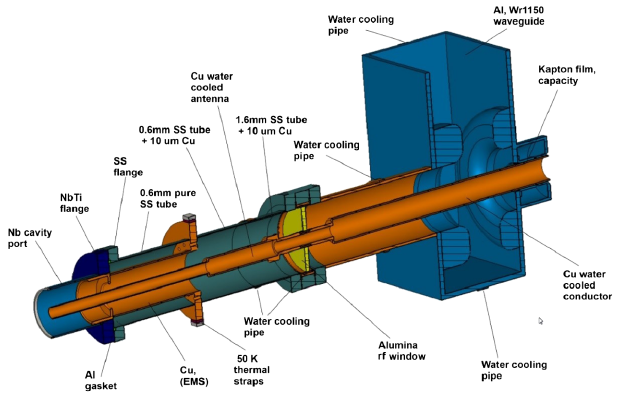
FIG. 16. Cut view of configuration of 650 MHz, 500 kW, cw coupler.